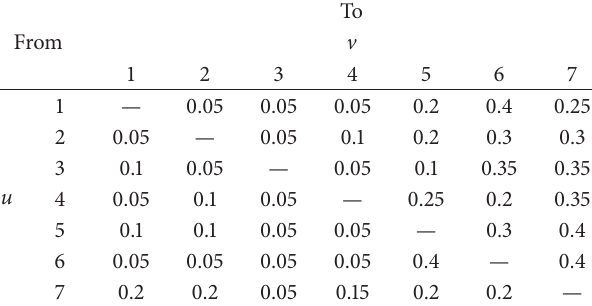
Table 2: Passenger destination probability 𝜌 𝑢 V